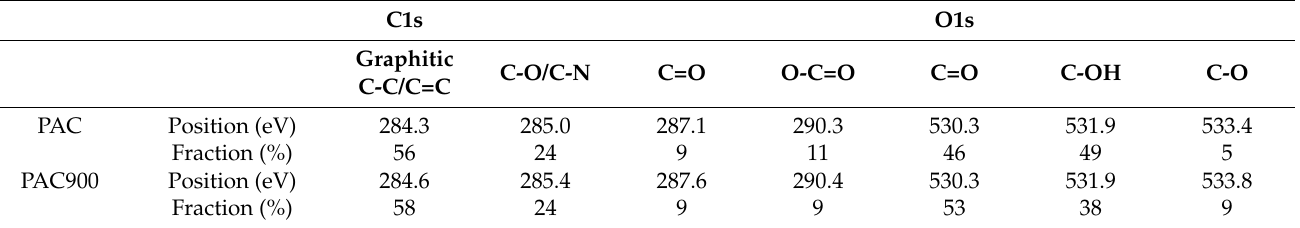
Table 3. The results of XPS.